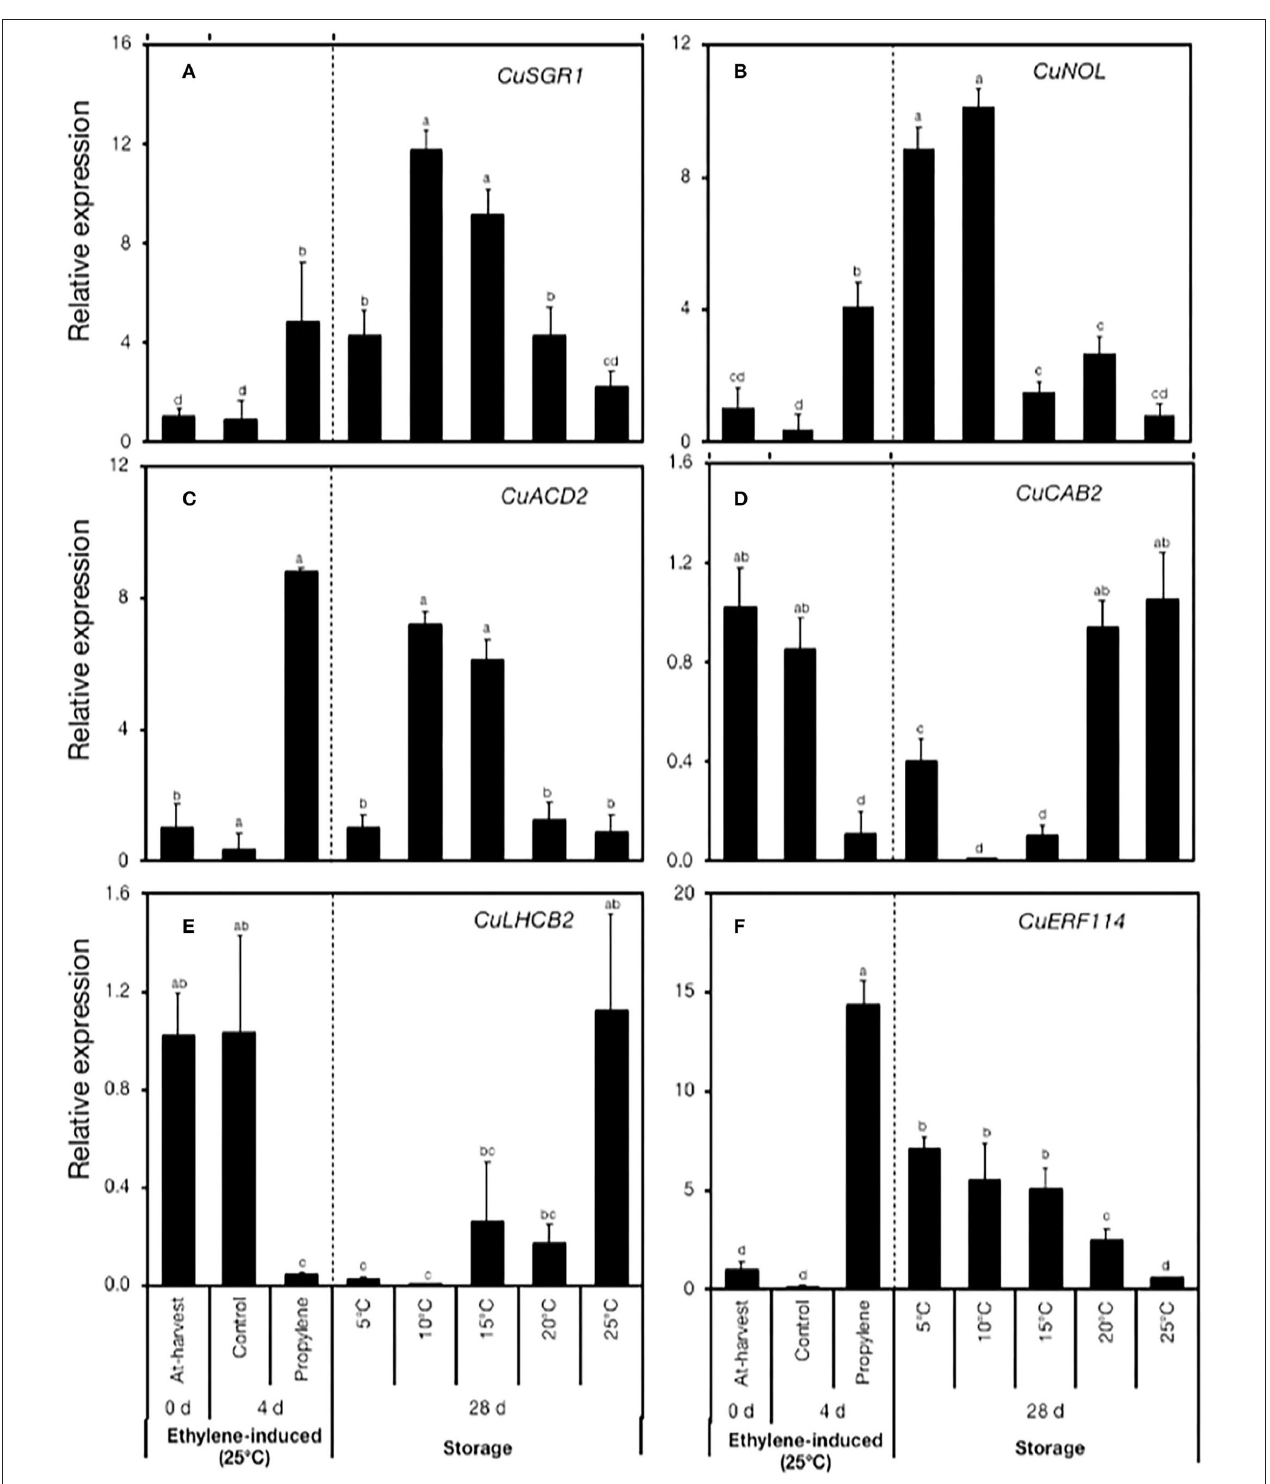
FIGURE 5 | RT-qPCR analysis of the expression of genes associated with chlorophyll degradation and a transcription factor selected from the RNA-Seq data. (A) CuSGR1 ( Ciclev10021651m .g), (B) CuNOL ( Ciclev10008039m .g), (C) CuACD2 ( Ciclev10026248m .g), (D) CuCAB2 ( Ciclev10016286m .g), (E) CuLHCB2 ( Ciclev10016280m .g), and (F) CuERF114 ( Ciclev10032575m .g). Data points represent the mean ( ± SE) of three fruit and different letters indicate significant differences in ANOVA (Tukey’s test, P < 0.05).